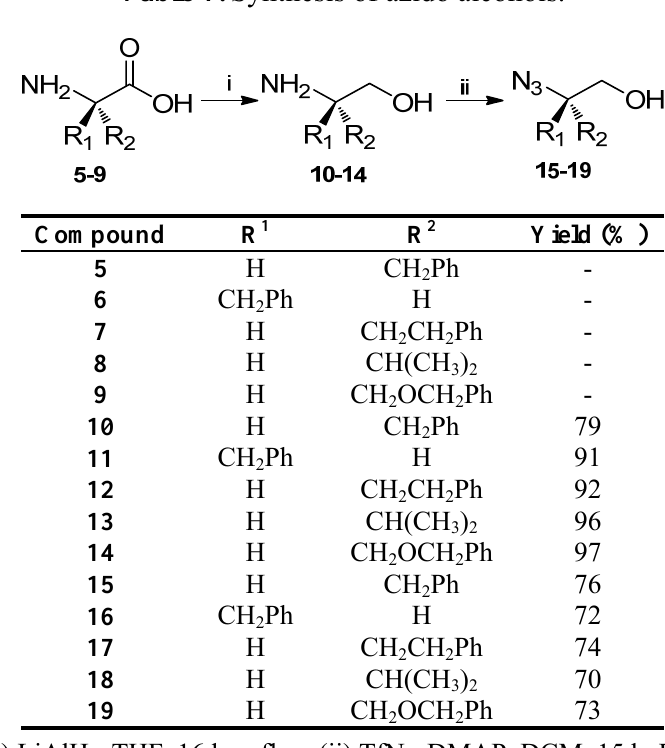
Table 1. Synthesis of azido